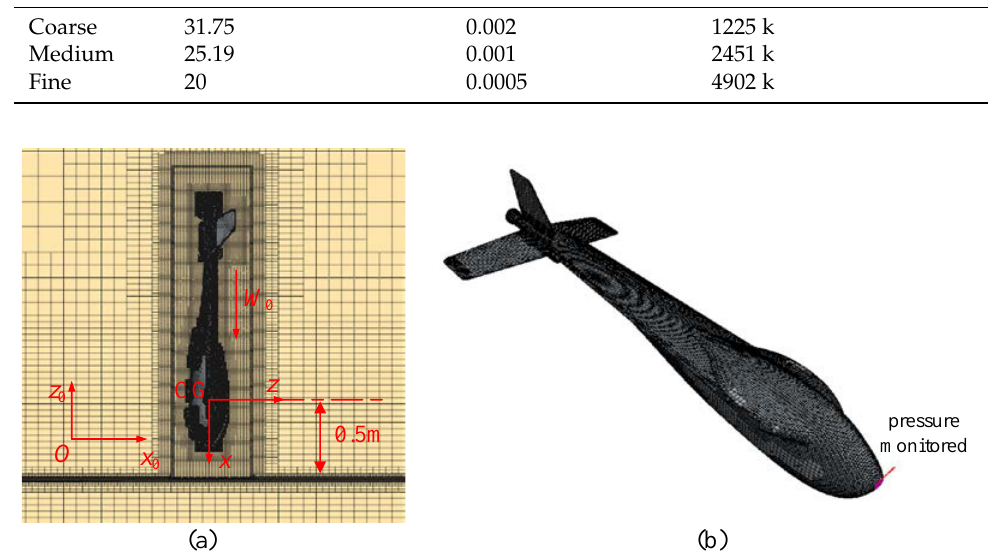
Figure 6. The sketch of the CFD mesh generations: ( a ) cross-view details; ( b ) mesh partition of the UAUV surface.